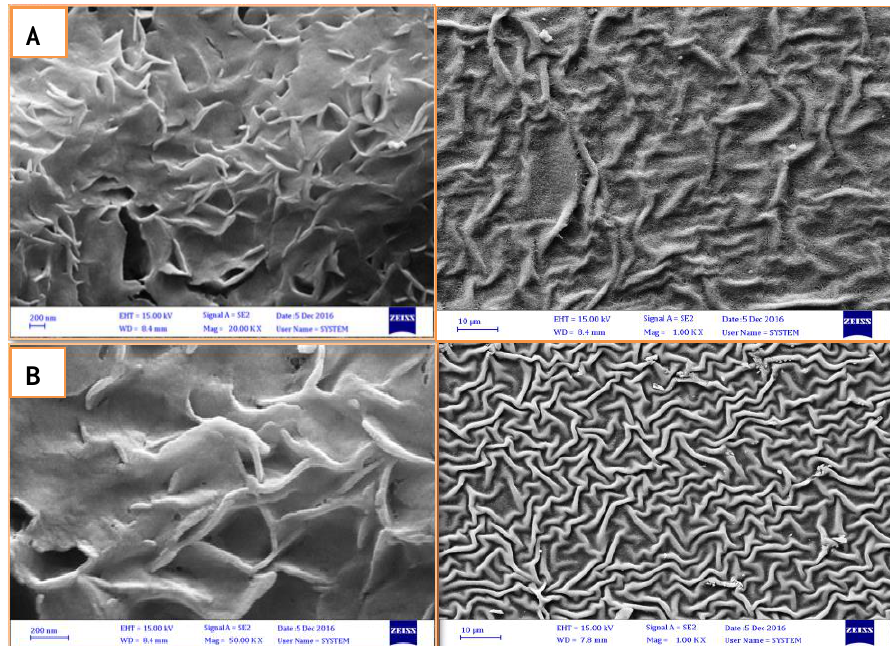
Fig.7: The FE-SEM image (top view) of ZnO thin films: (A) Pure ZnO (B) Fe- ZnO 4 %.